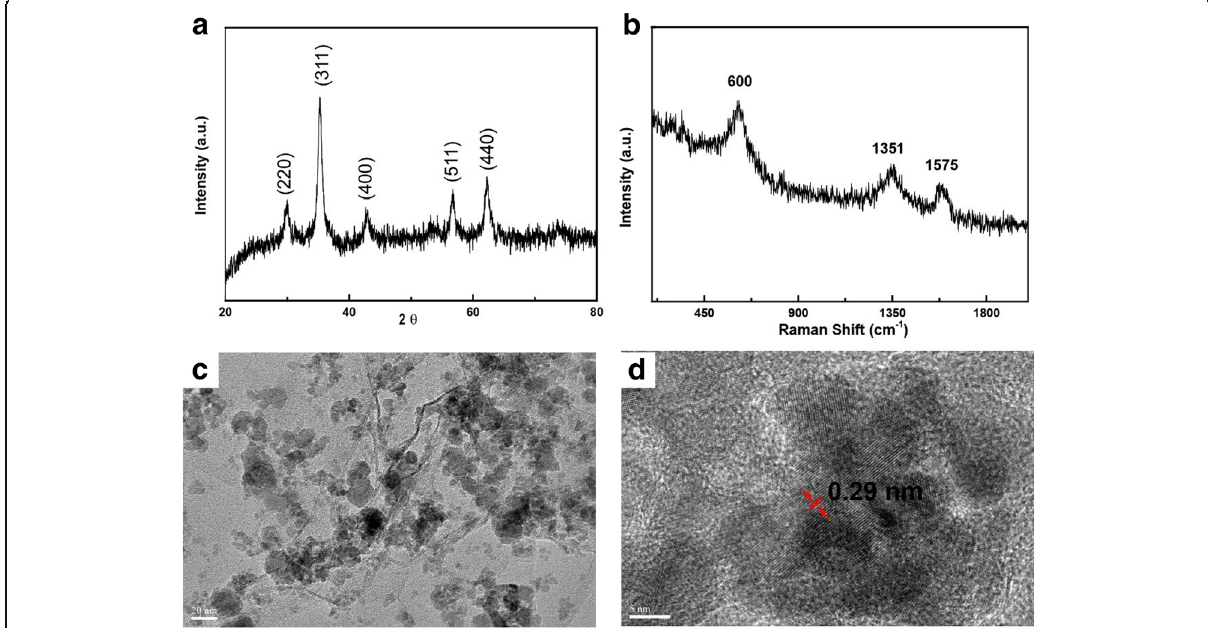
Fig. 2 Characterization of the MnFe 2 O 4 /rGO nanocomposite. a XRD patterns and ( b ) Raman analysis of the nanocomposite; TEM image ( c ) and HRTEM image ( d ) of the